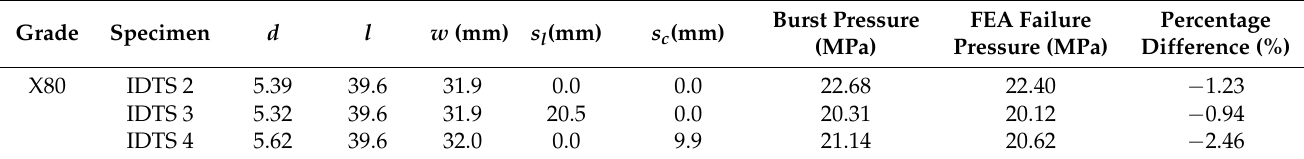
Table 7. FEM failure pressure validation against full scale burst tests by Benjamin et al. for interacting corrosion defects [56]. Grade